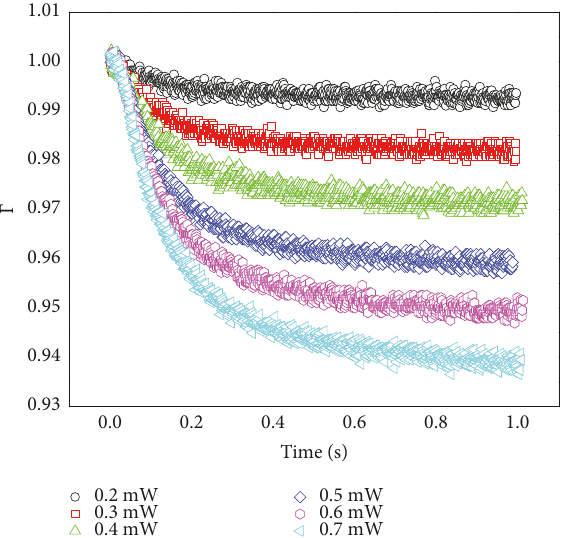
Figure 7: Normalized transmittance for a sample of stock colloid as a function of the power of the pump beam.